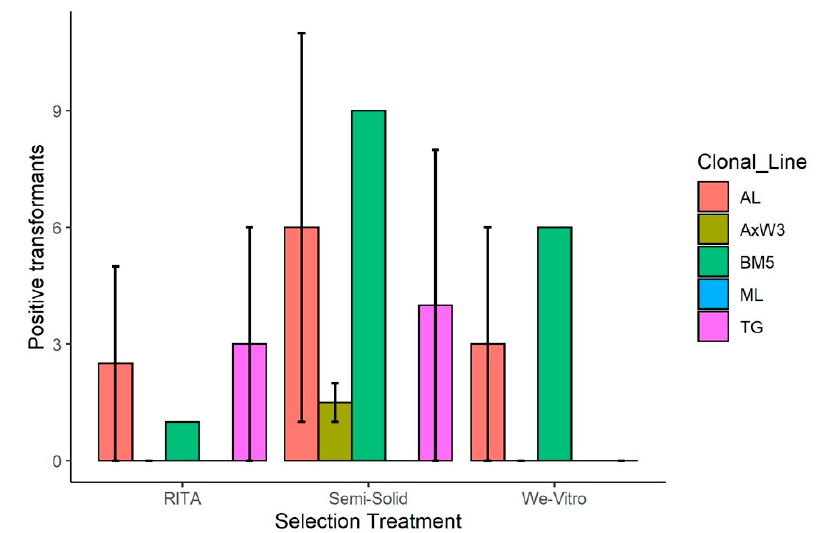
Figure 3. Number of American chestnut transformation events with the oxalate oxidase gene after 4 weeks of selection in RITA ® bioreactors, semisolid media in Petri plates and We Vitro containers. Error bars indicate standard error of the mean. Two clonal lines, Bass Mountain #5-1B (BM5) and Moss Lake 90016 C-21-1C (ML), were only used in single trials.